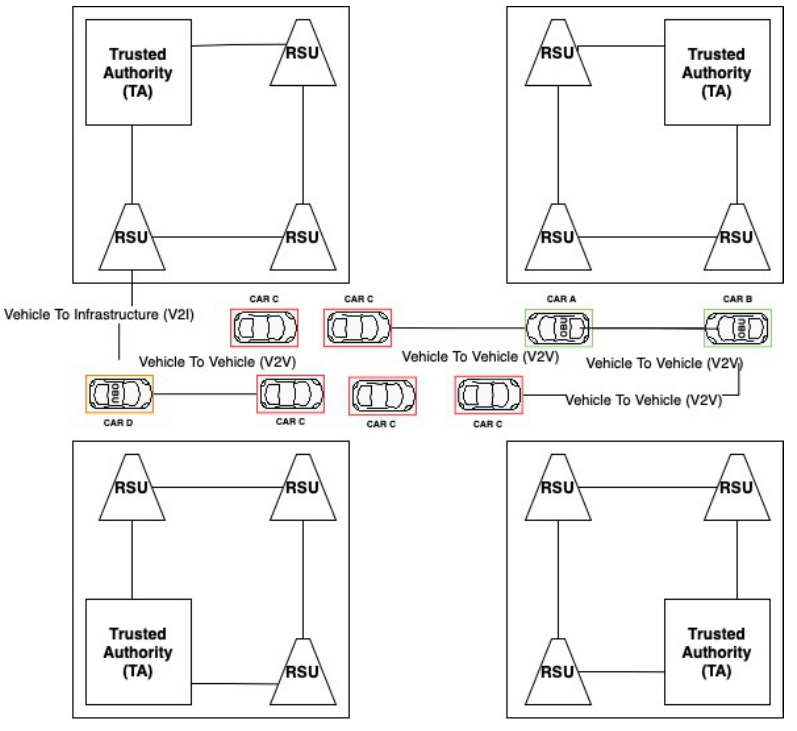
Figure 3. Sybil attack in